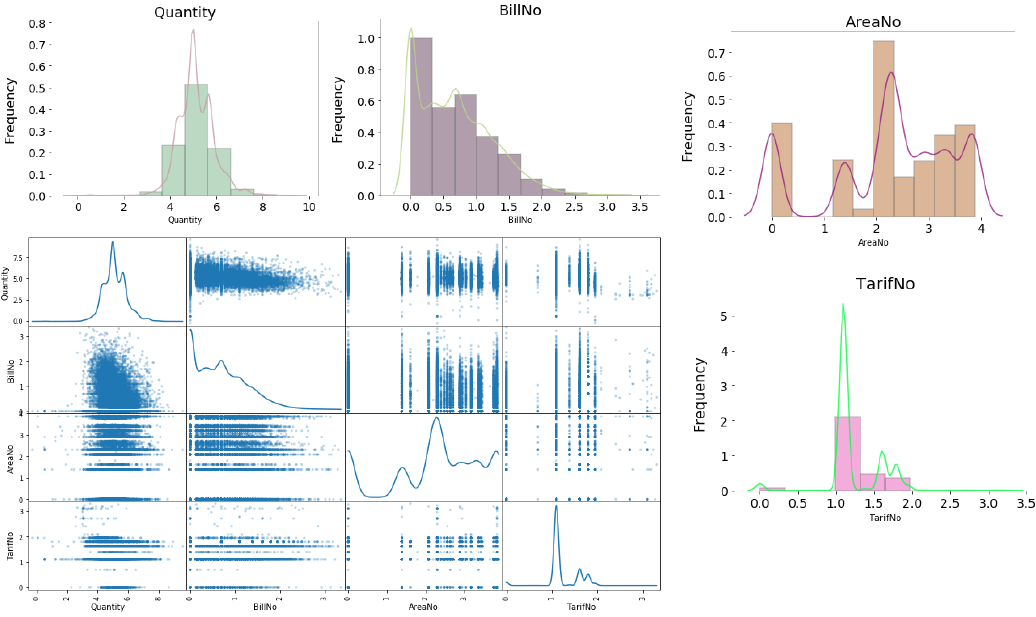
Figure 11. ECPB data set variables distribution and